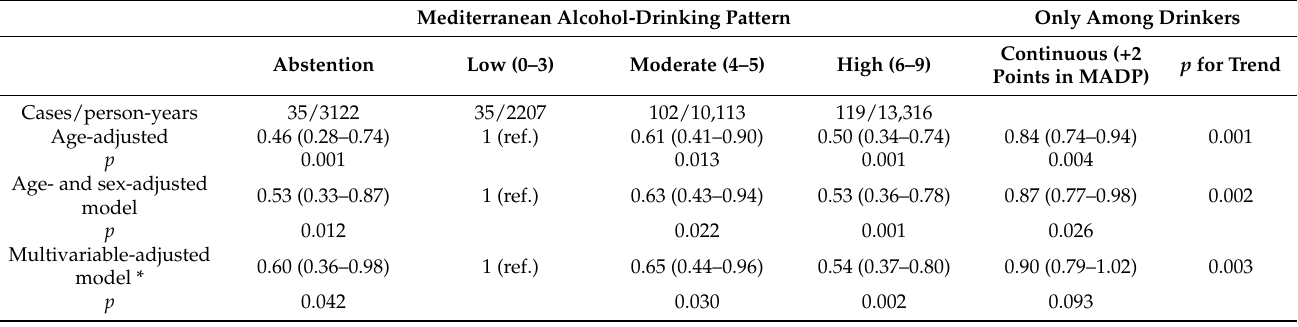
Table 2. Mortality hazard ratios (HR) and their confidence intervals (95% CI) according to the categories of the MADP score and for each two-point